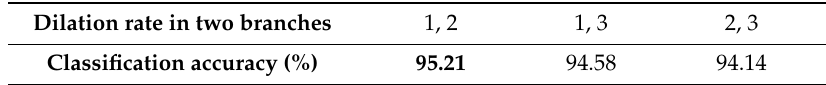
Table 5. Accuracy on the Google dataset of SIRI-WHU with di ff erent dilation rates in the multiscale feature extraction module.